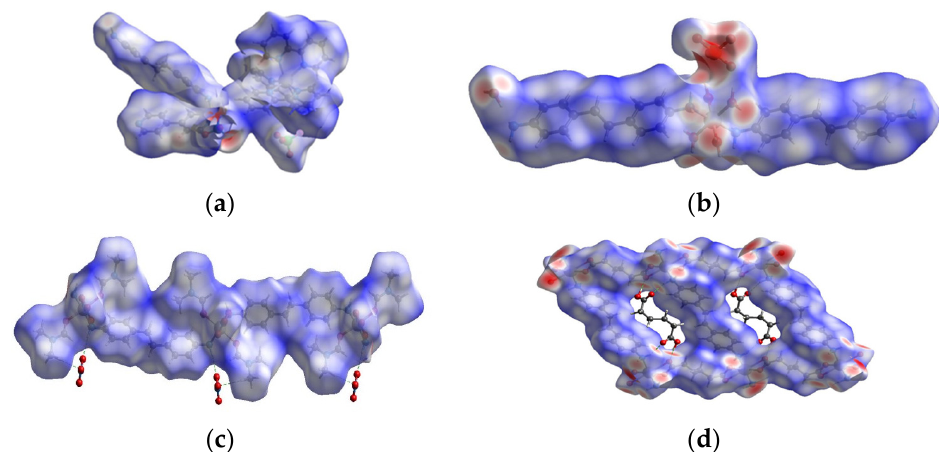
Figure 8. Hirshfeld surfaces mapped with d norm ranging from − 0.40 Å (red) to 2.40 Å (blue) for crystal structures 1 ( a ) , 2 ( b ) , 3 ( c ) and 7 ( d ).